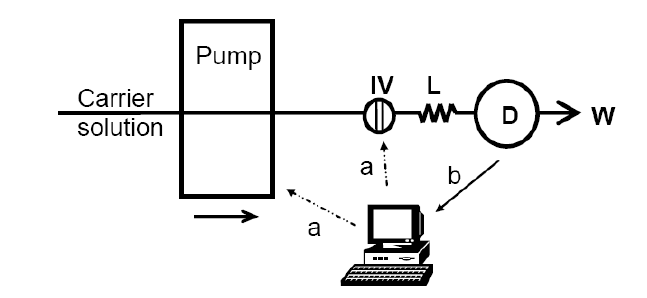
Figure 3. Automated Flow Injection Analyzer. D: detector unit; IV: injection valve; L: mixing coil; W: waste; a: digital control signals; and b: data acquisition